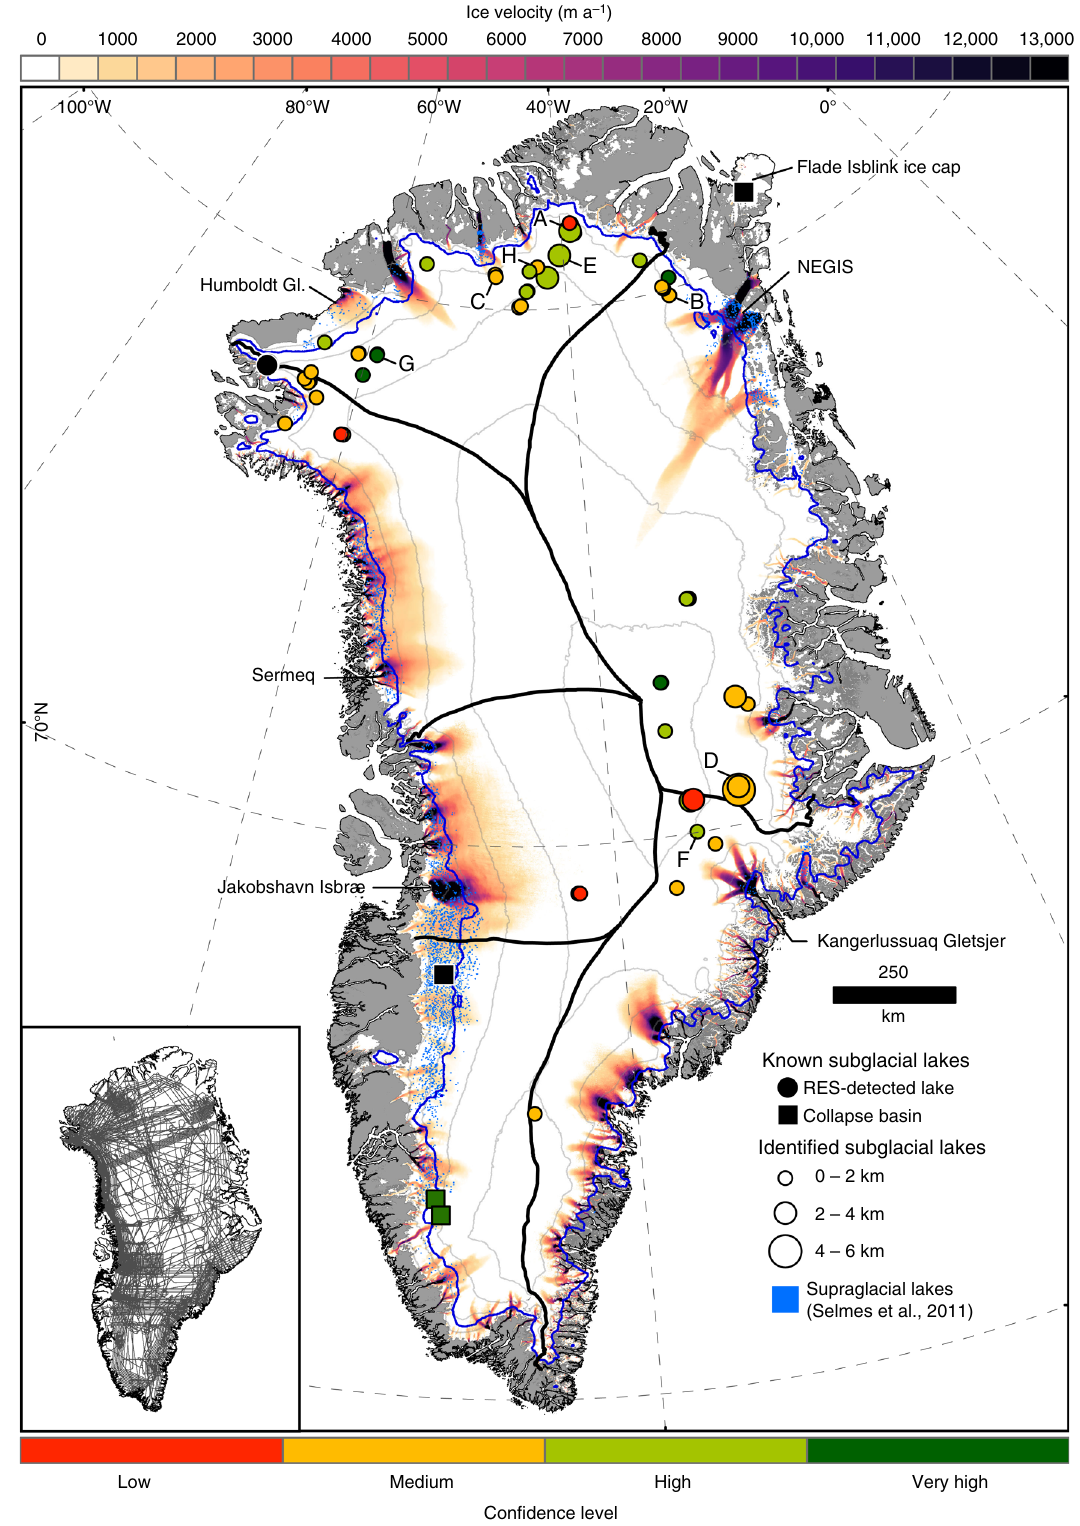
Fig. 3 Spatial distribution of subglacial lakes identi fi ed in the radar echo sounding data. Lakes are colour-coded according to con fi dence level and proportionate in size to the length of the lake re fl ector. Black circles represent known subglacial lakes, squares depict collapse basins (black = in existing literature, green = this study). Ice-surface elevation contours at 500 m intervals are shown in grey 28 , with the equilibrium line altitude in blue (for the period 2000 – 2009) using MAR 3.5 forced by ERA-Interim 63 and ice divides depicted by the thick black lines 64 . Supraglacial lake data derived from MODIS between 2005 – 2009 is also displayed 65 . Background map shows MEaSUREs Greenland Ice Sheet velocity map derived from InSAR 66 . Inset map displays OIB radar fl ight lines (1993 – 2016) used in this